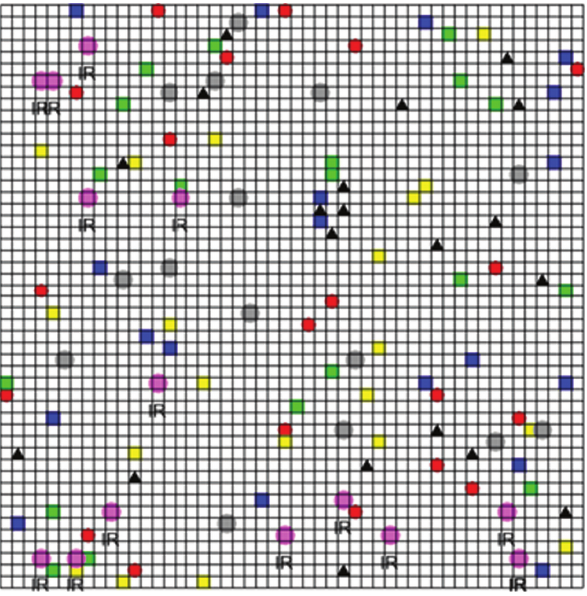
Figure 4. Simulation with Red, Blue, Yellow, and Green Boxes. Agents performing intent recognition are in purple. Observed agents are gray. Triangles represent